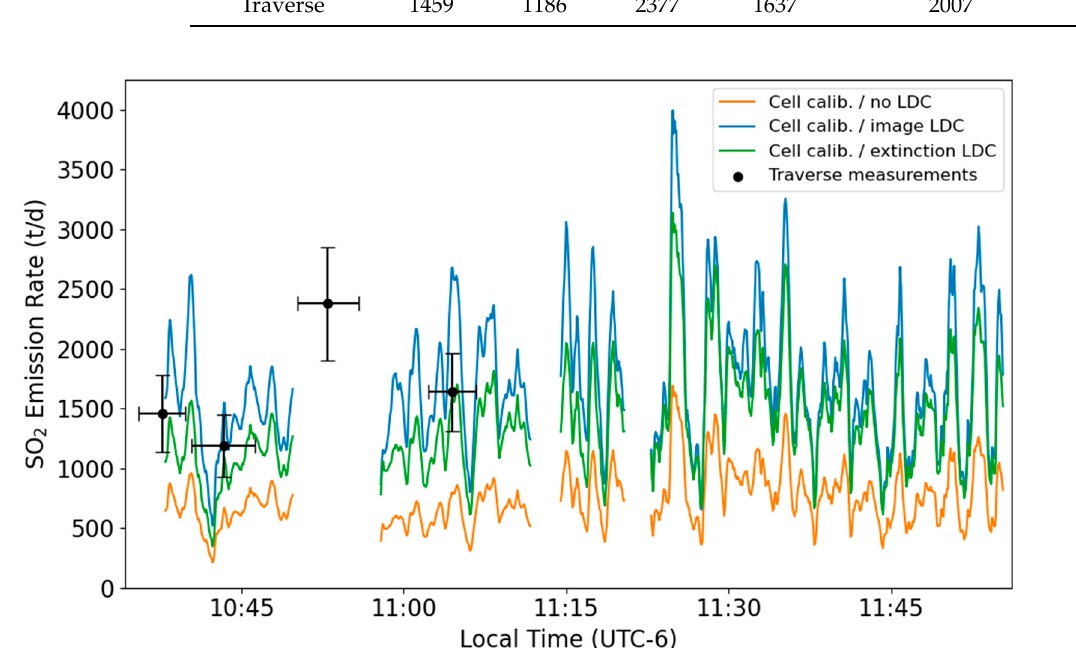
Figure 7. ( a ) Scattering efficiency for the image ‐ based correction (blue) and the light dilution factor (LDF) for the spec ‐ trometer correction (red) plotted for the duration of the measurement period on the 15 January 2018; ( b ) spectrometer ‐ calibrated (purple and red) and cell ‐ calibrated SO 2 emission rates (orange and blue) for processed camera data. The spec ‐ trometer ‐ calibrated emission rate has been light dilution ‐ corrected (LDC) using dual ‐ waveband modelling (red), whilst the cell ‐ calibrated emission rate had been light dilution ‐ corrected using an image ‐ based correction. Our suggested meth ‐ odology of combining spectrometer calibration (dual ‐ waveband corrected) with image ‐ based corrections is shown as the thick black line. Traverse measurements (black points with error bars) are also shown as a reference.